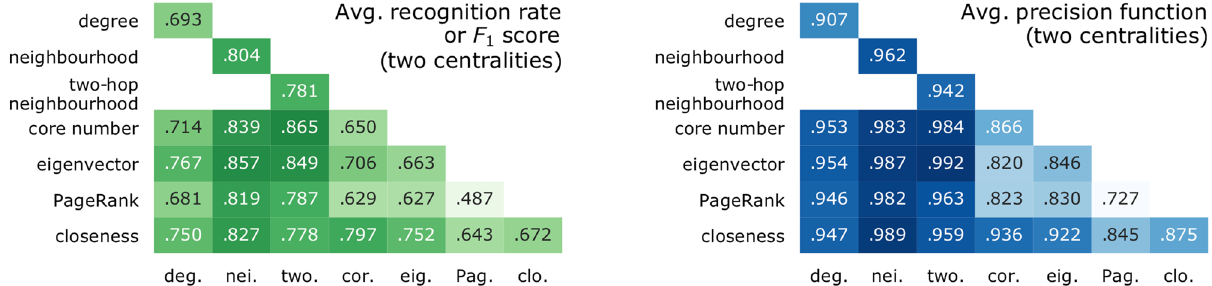
Figure 9. The success of single and pairs of centralities at predicting spreaders: for each pair of centralities, the average performance score across all networks and values of f . The diagonal is the result of ranking by a single centrality and it is scored by the recognition rate and the precision function. The rest of the matrix is the result of classification by two centralities and is scored by the F1 score and the precision function.